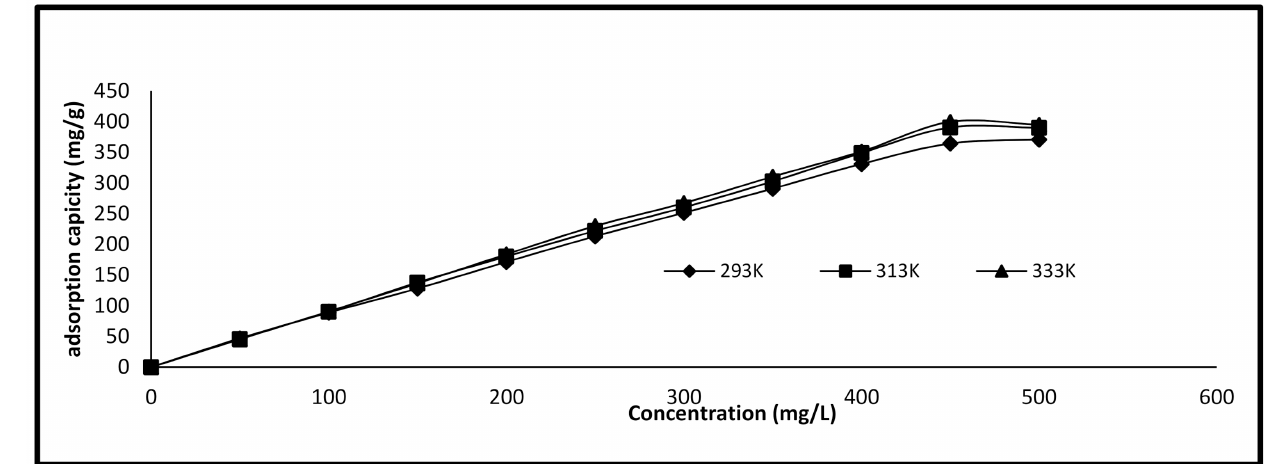
Figure 9. Absorption isotherm equilibrium for adsorption of AO-8 on Pd-Ni/AC-CeO 2 .